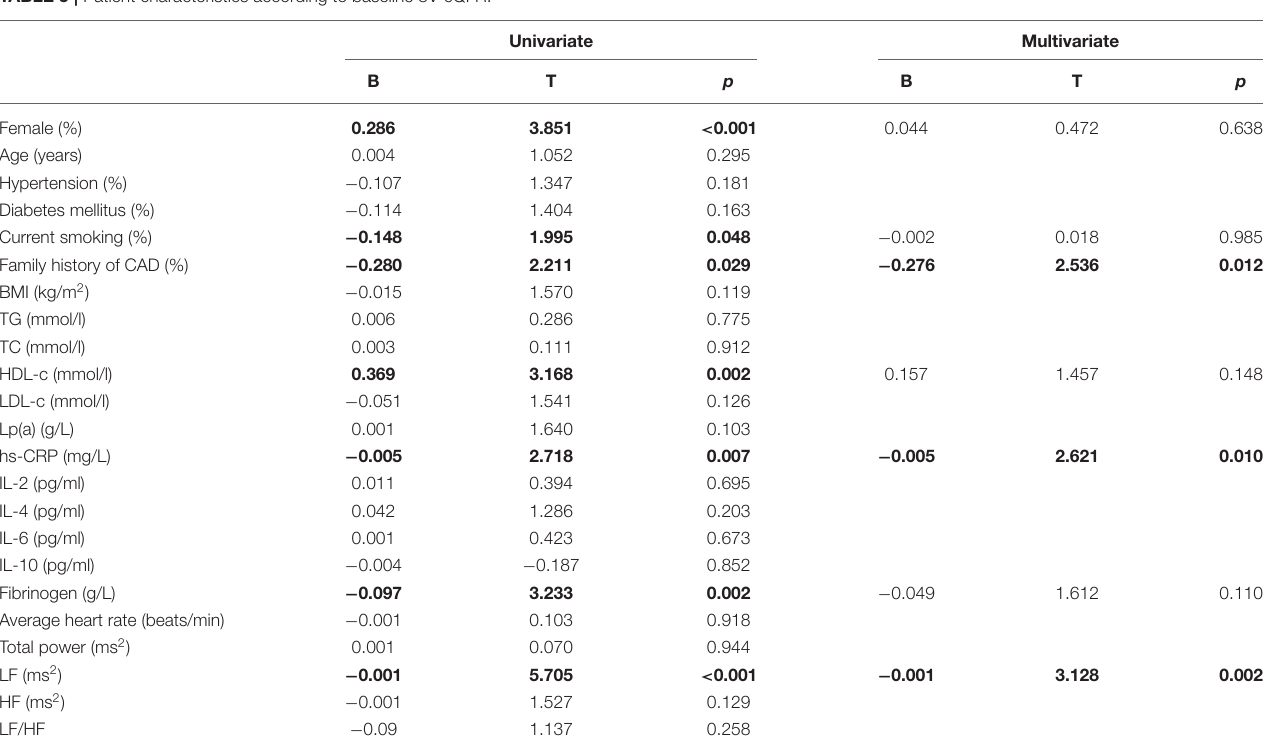
TABLE 5 | Patient characteristics according to baseline